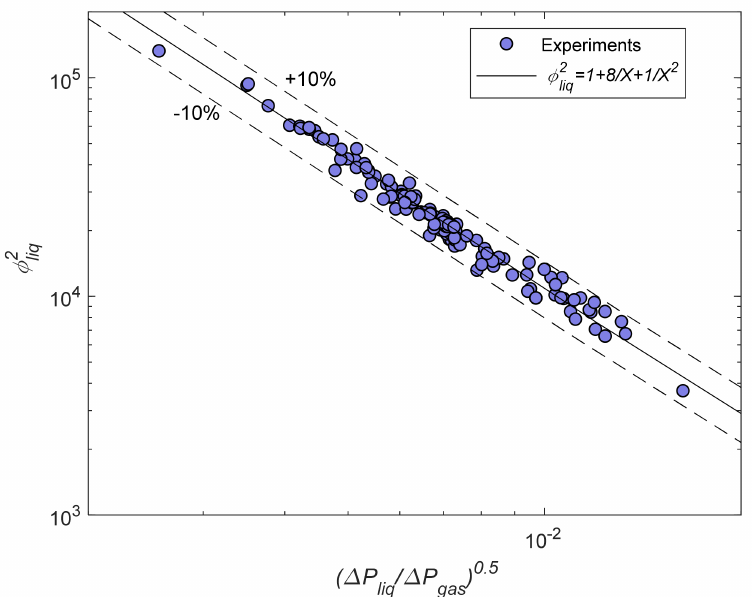
Figure 8. Two phase multiplier factor as a function of the Martinelli parameter considering X = √ ∆ P ∆ P L / G , and prediction of the Ishihara